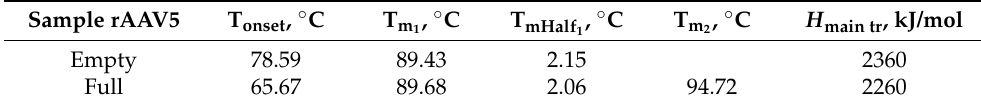
Table 8. Thermal stability results of empty and full rAAV5 samples obtained from